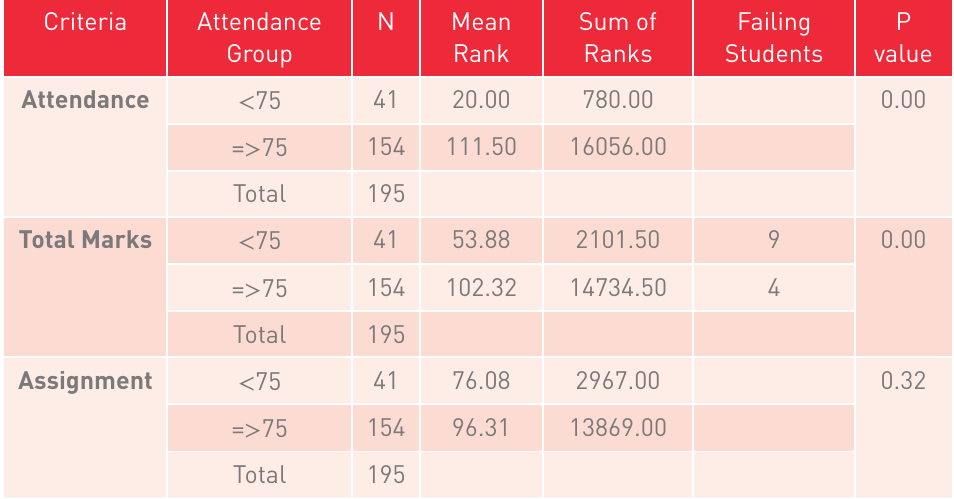
Student attendance, average marks and fail count for 2017.